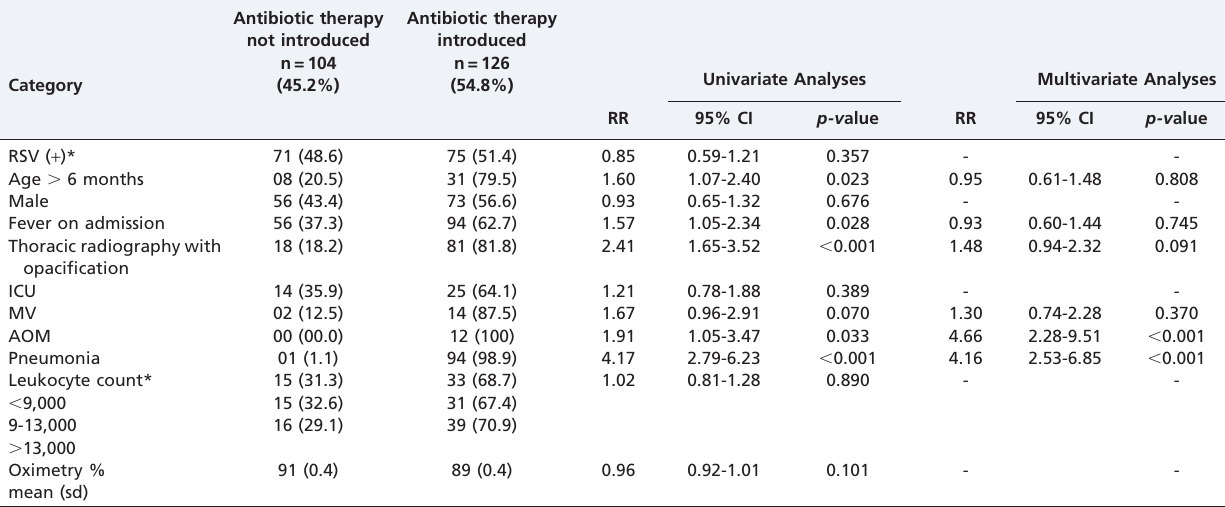
Table 3 - Univariate and multivariate analyses of the possible determinants of the introduction of antibiotic therapy upon admission of the 230 patients included in the